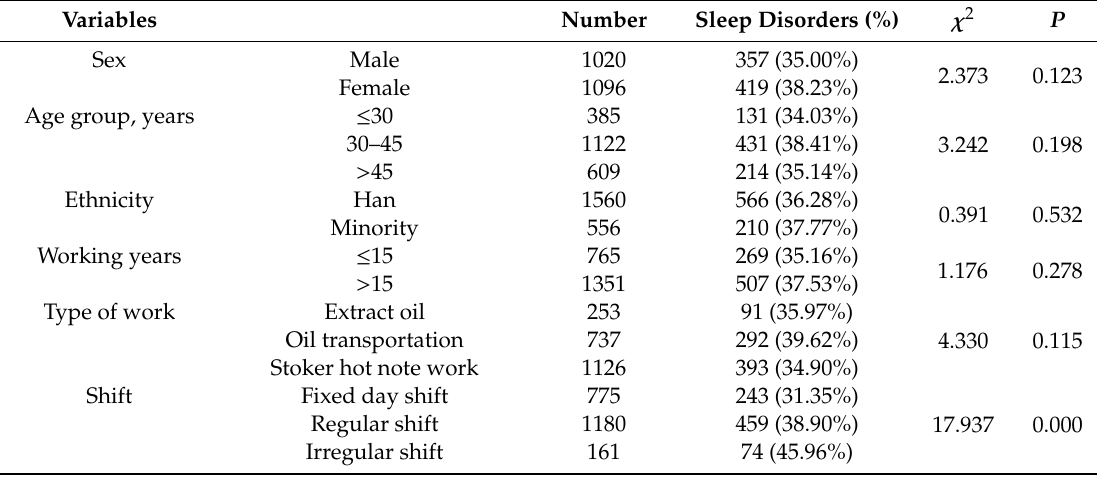
Comparison of the incidence of sleep disorders according to di ff erent population characteristics